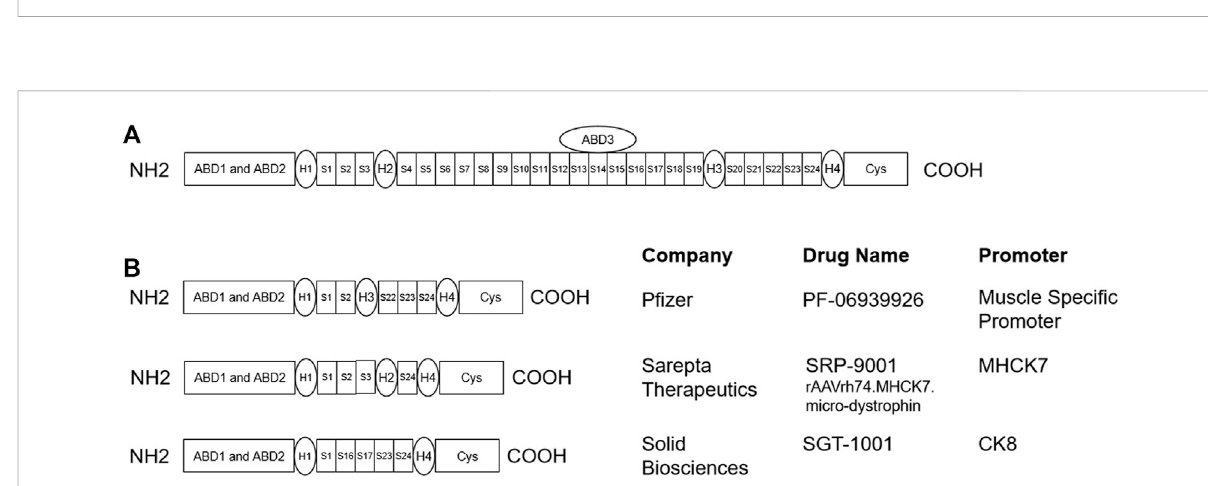
FIGURE 2 (A) Schematic for full length dystrophin protein (Hoffman et al., 1987): the actin-binding domains (ABD1-ABD3) bind to the intracellular cytoskeleton network of muscle cells, and the cysteine-rich (Cys) domain binds to β -dystroglycan, which is connected to the extracellular matrix protein laminin. The amino terminal and Cys domain are connected by 24 spectrin-like repeats (S1-S24) and 4 hinge domains (H1-H4). (B) Schematics for microdystrophin gene therapy candidates, which are truncated versions of the full length dystrophin, that are currently under development (Wang et al., 2000; Harper et al., 2002; Schneider et al.,